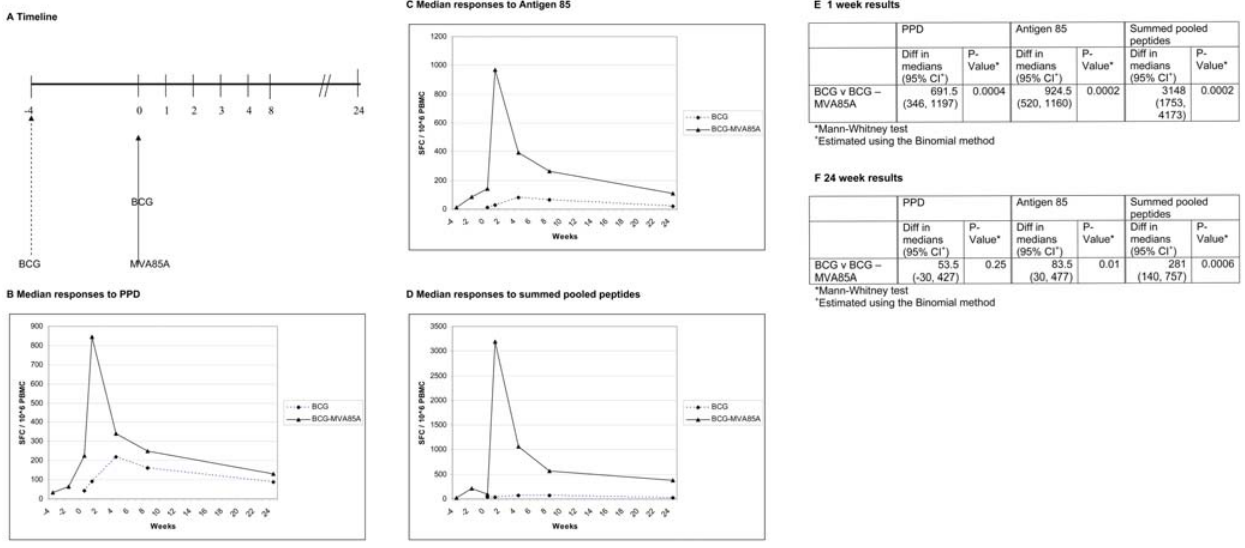
Figure 4. Median IFN- c ELISpot responses after vaccination in each vaccination group: BCG alone;BCG prime-MVA85A boost . ( a ) timeline for vaccinations (weeks) in each group; ( b )Tuberculin PPD responses; ( c ) Purified antigen 85 protein responses ( d ) summed pooled peptide responses; ( e ) For each of the three antigens measured, the responses between each vaccine group were compared 1 week after vaccination using Mann-Whitney statistic. ( f ) For each of the three antigens measured, the responses between each vaccine group were compared 24 weeks after vaccination using